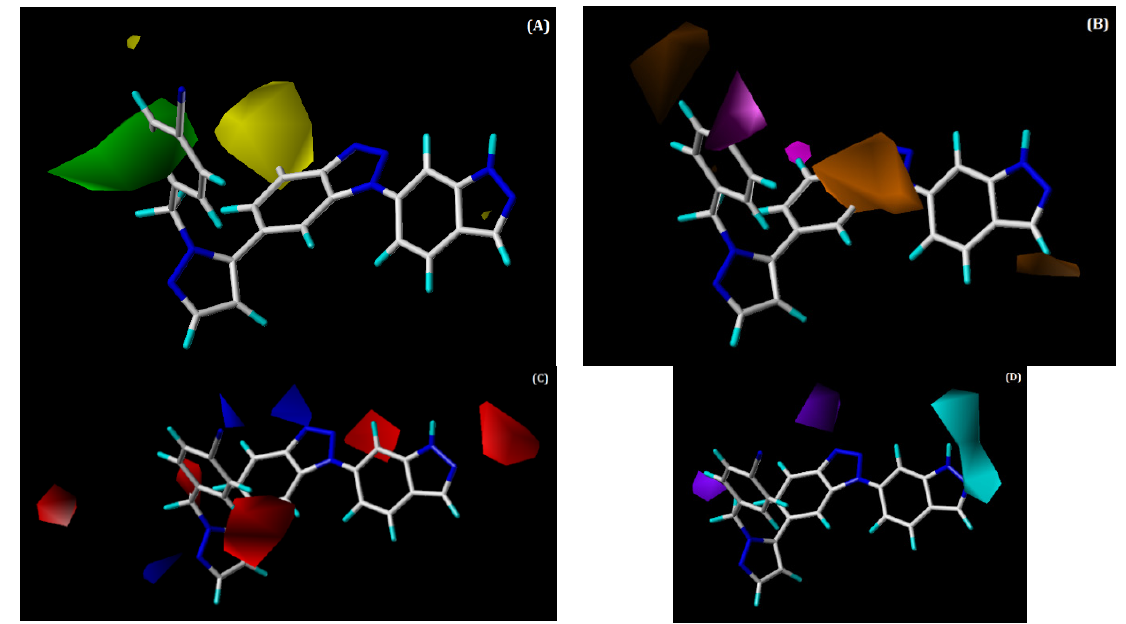
Figure 6. Contour maps for the selected CoMSIA model. ( A ) Steric contour map; ( B ) hydrophobic contour map; ( C ) hydrogen bond acceptor contour map; ( D ) hydrogen bond donor contour map. Green contour shows regions that are favourable for bulky substitutions, whereas yellow contours show unfavourable regions; magenta contour shows the region favourable for hydrophobic substitutions, whereas orange contours show unfavourable regions; blue contours favour H-bond acceptor, while red contour does not favour H-bond acceptor substitutions. The favourable region of the hydrogen bond donor contour map is depicted by cyan, whereas purple denotes the opposite.